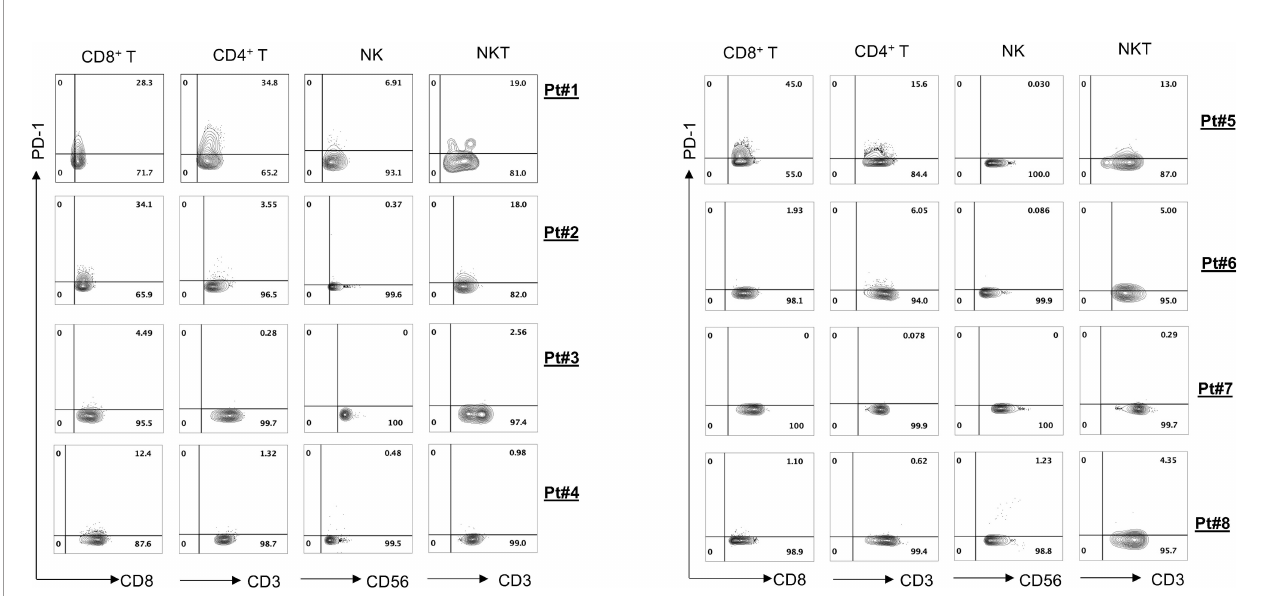
FIGURE 3 | PD-1 expression on various lymphocyte cell subsets. Tumor-in fi ltrating leukocytes were isolated from fresh tumors of 8 clear cell renal cell carcinoma (ccRCC) patients and then stained with different antibodies against the cell surface. Fluorescence-activated cell sorting (FACS) plot showed PD-1 expression on different lymphocyte